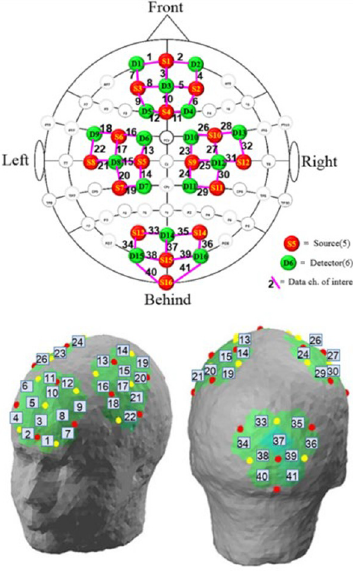
Figure 2 The DS used in this study